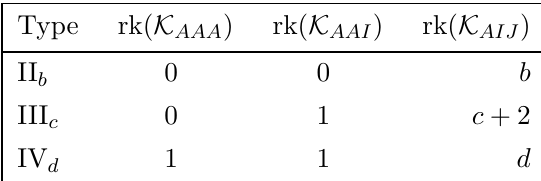
) and rk( ) are either 0 or 1 depending on K AAA K AAI